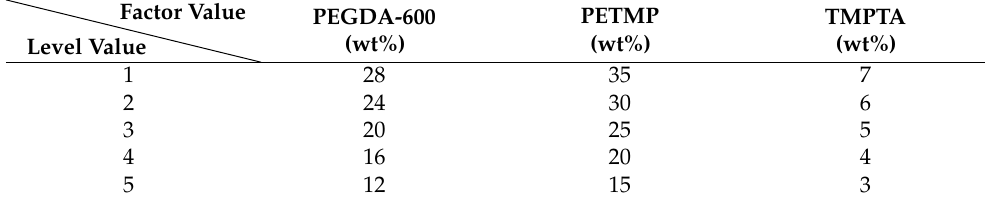
Figure 1. Chemical structures of monomers used in this study. Table 1. Factor value and level value of the experimental design.